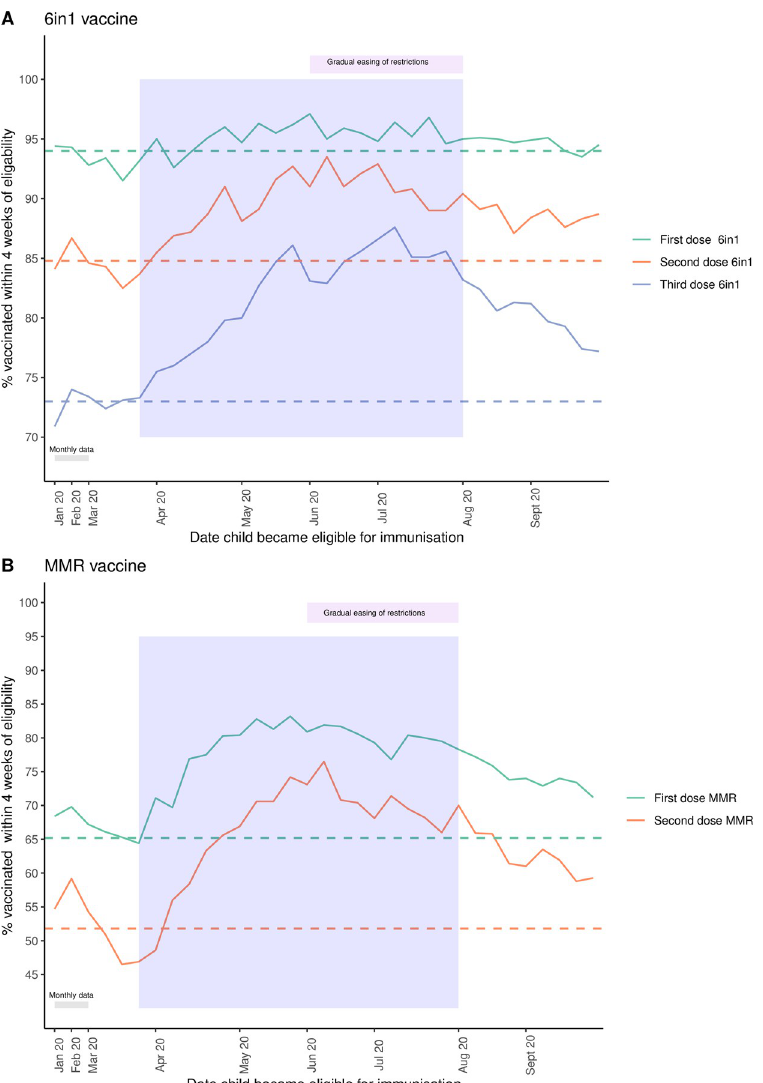
Fig 1. Percentage of children in Scotland immunised within 4 weeks of eligibility. (A) All doses 6-in-1 vaccine; (B) MMR vaccine across January to September 2020 in Scotland. Lockdown period = blue shaded area. For January and February, a single mean monthly value is plotted, and from March onwards, weekly uptake is shown (see S2 Table for full data). Dashed horizontal lines (—) indicated the mean uptake in 2019 of the immunisation with the corresponding colour. The increase in uptake during the lockdown period was statistically significant (see Table 1 for details). MMR AU : AbbreviationlistshavebeencompiledforthoseusedinFigs 1 (cid:0) 4 : Pleaseverifythatallentriesarecorrect : , measles, mumps, and rubella.